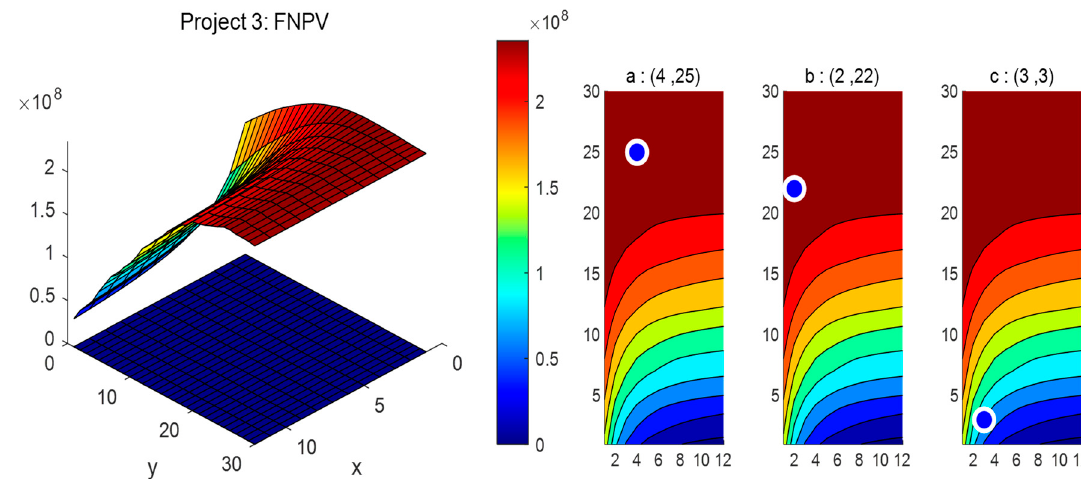
Figure 22. Decision − making for project 3. Figure 22. Decision-making for project